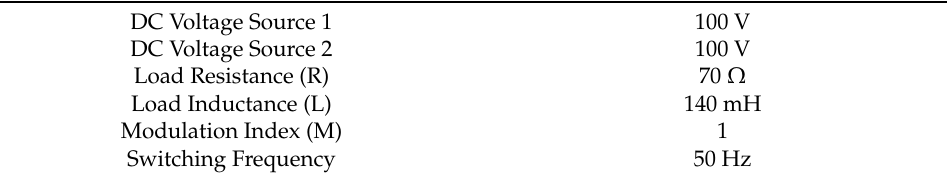
Table 10. List of simulation